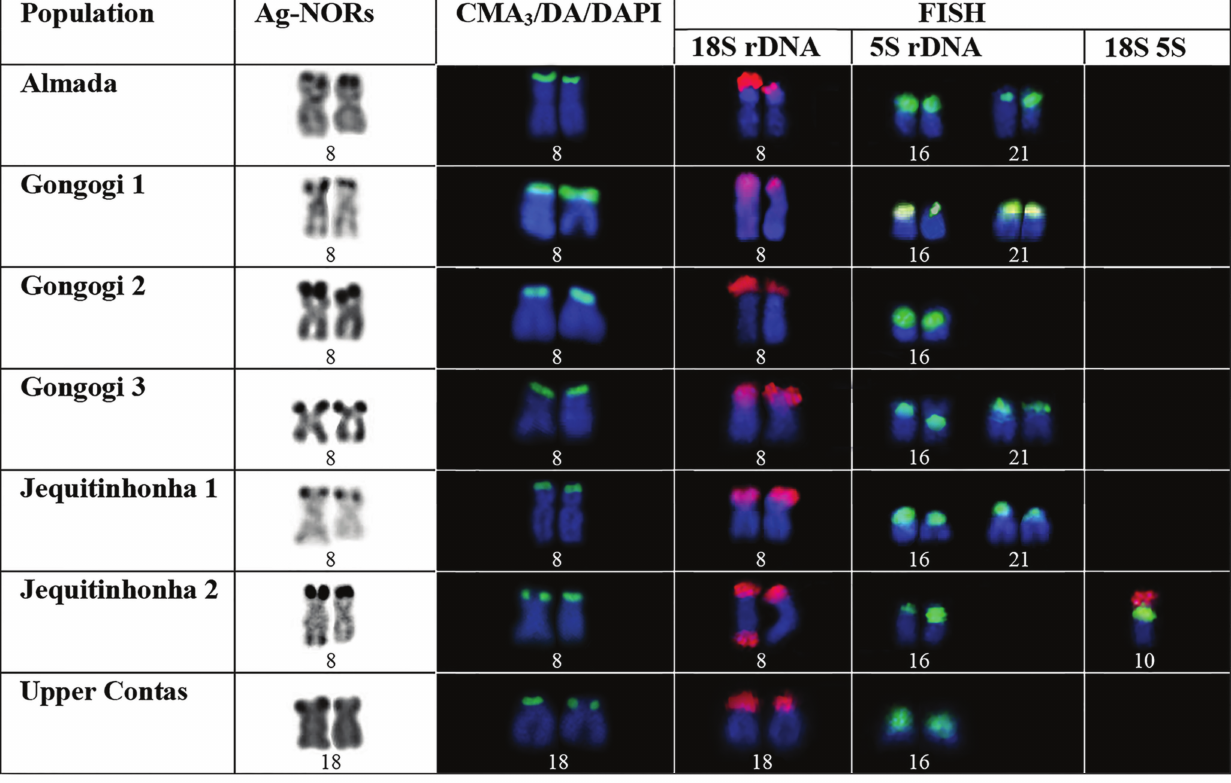
Fig. 4. Chromosomes of distinct populations of Nematocharax venustus after silver nitrate staining (Ag-NORs), base-specific fluorochrome staining (CMA /DA/DAPI) and FISH with 18S (magenta) and 5S rDNA probes (green). Bar = 5 3